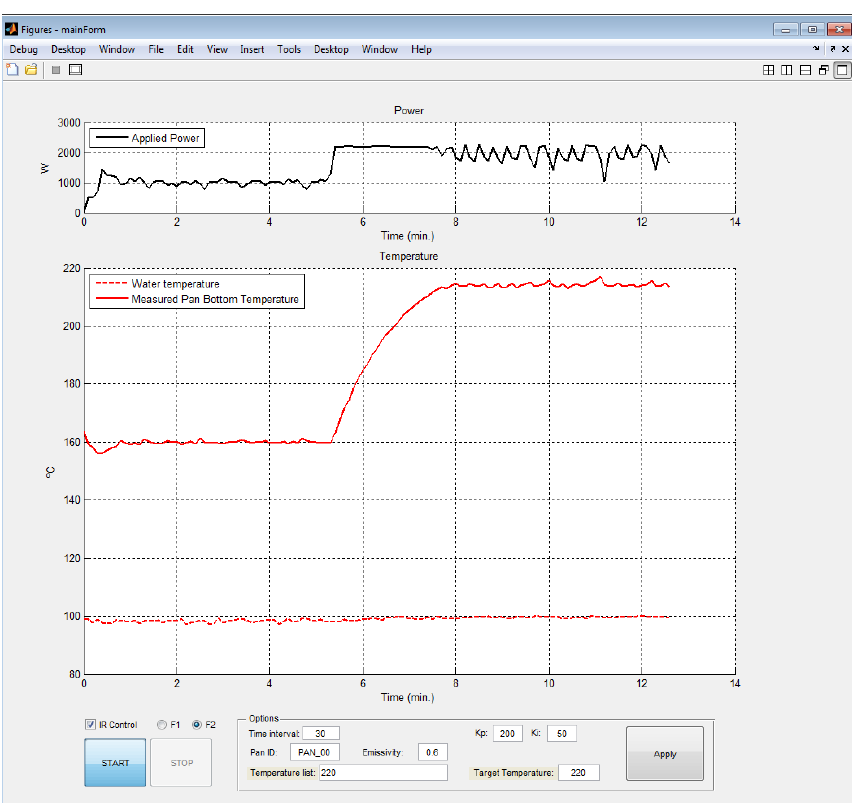
Figure 8. Software interface